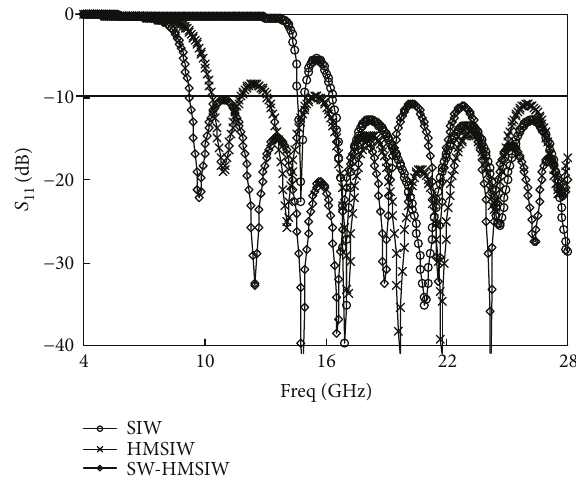
Figure 4: Simulated | S integrated waveguides.